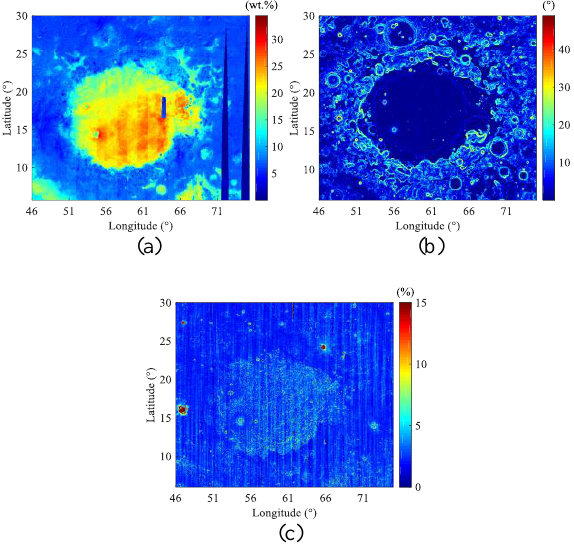
Figure 5. FTA (a), surface slope (b), and rock abundance (c) of Mare